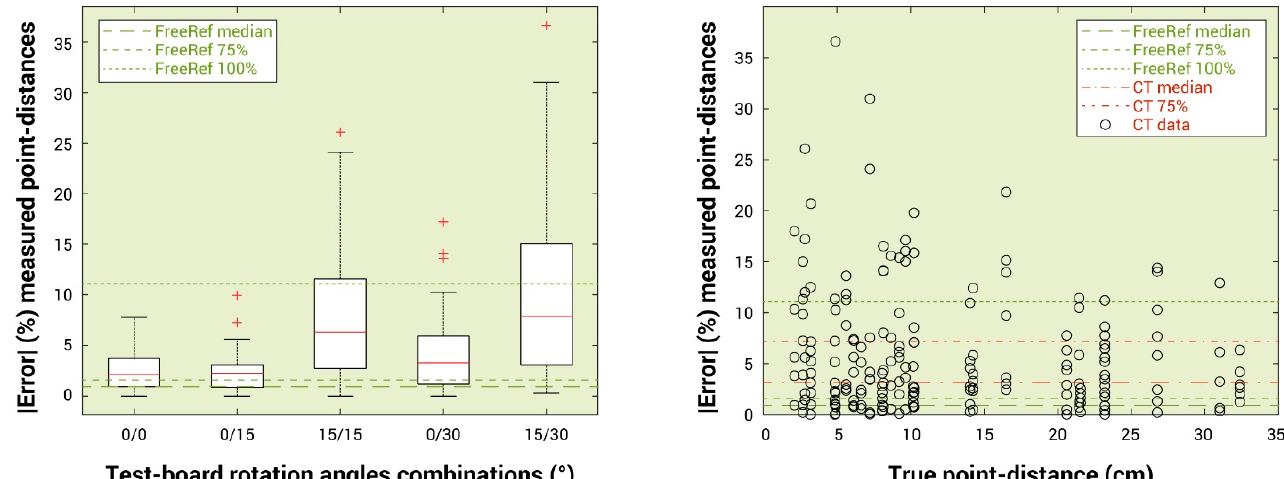
Figure 13. Point distance measurement errors made by the participants in the user tests. ( Left ) Box plot showing the participants’ measurement errors for the different combinations of Txx and Tyy rotations of the test board. Boxes indicate the 25 and 75% quartiles, the red center line in each box indicates the median and the whiskers are at the edges of the 0 and 100% quartiles, with red plus signs showing outliers. ( Right ) Scatter plot of the same data, sorted by true point distance. CT = current technique.